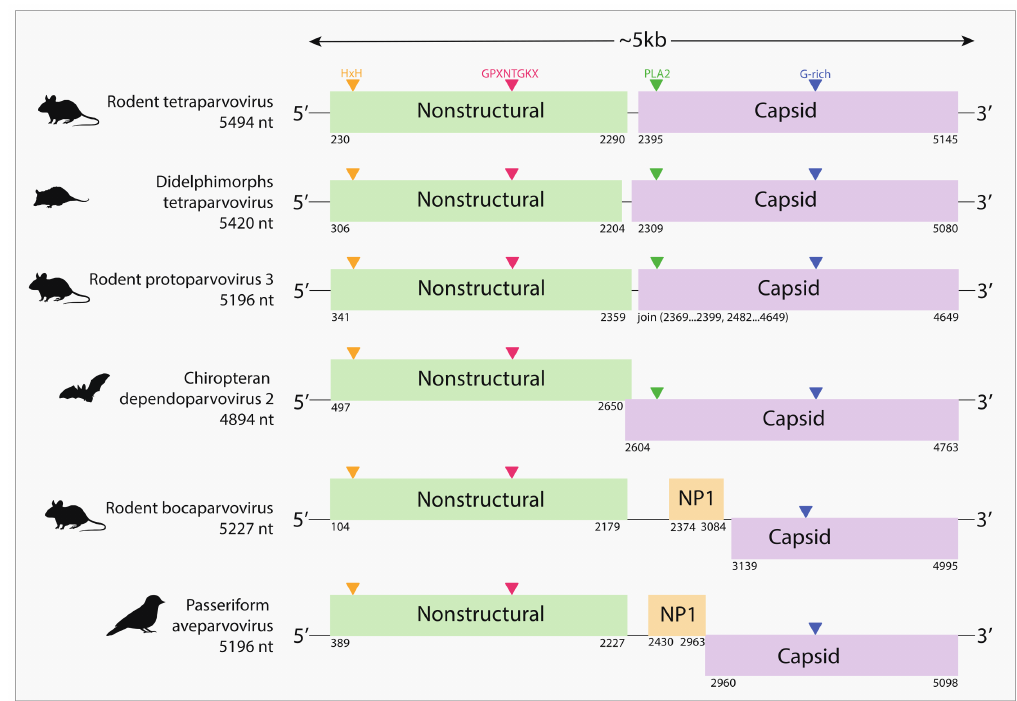
Figure 3. Genome structures of nearly complete coding sequences of newly identified parvoviruses. The length of the determined nucleotide sequences of the viral sequences are shown on the left. Boxes indicate the open reading frames (ORFs) and the number represents the respective position of their